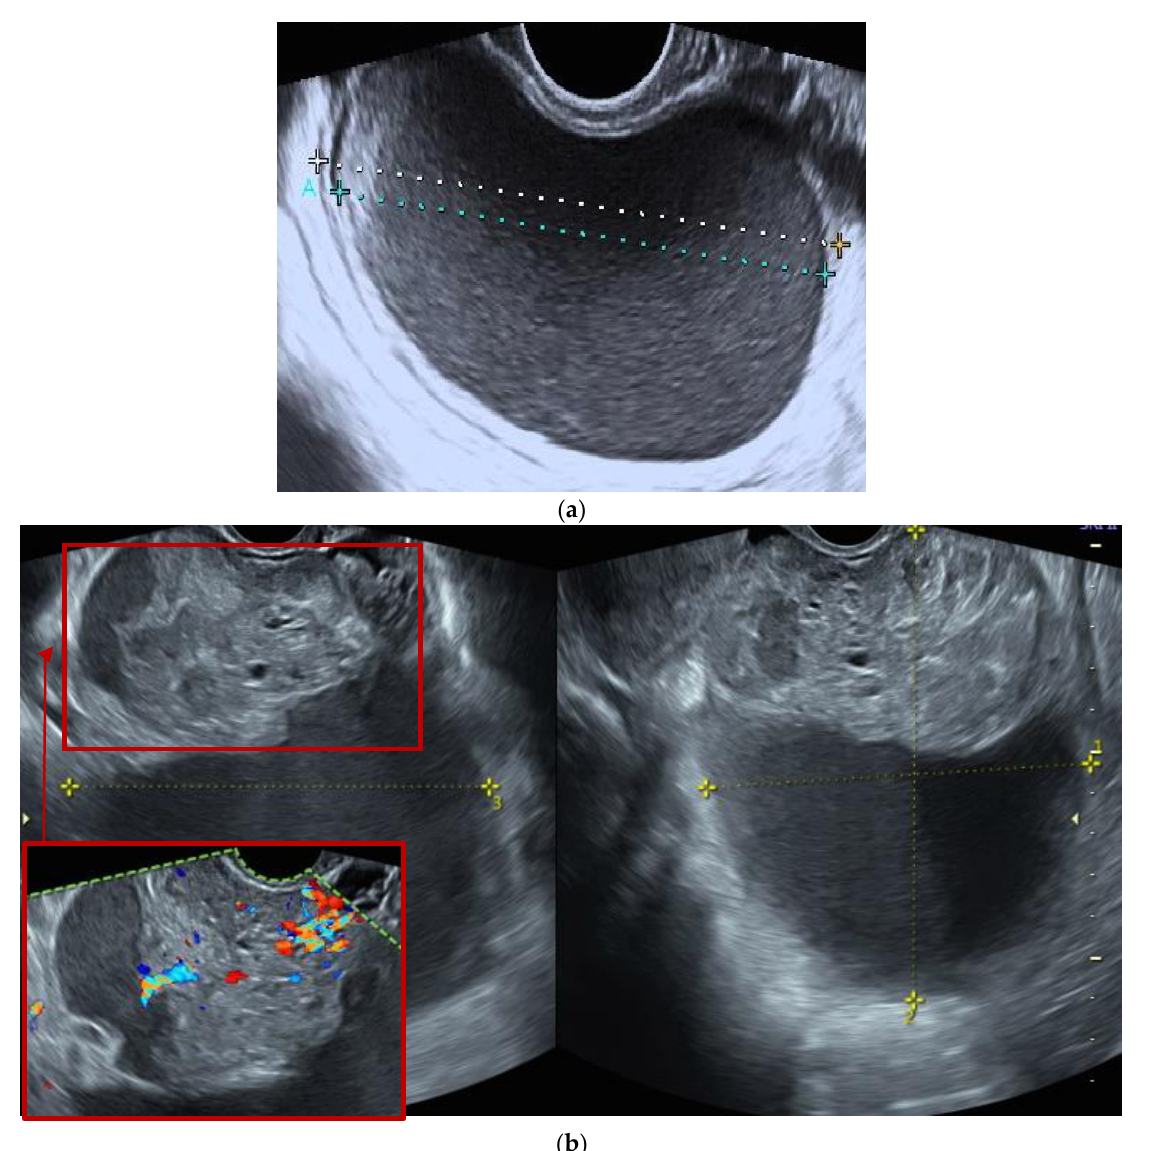
Figure 3. Ultrasound features of an ovarian mucinous carcinoma (FIGO IA stage) initially classified as a benign lesion. ( a ), Unilocular ovarian formation with “ground glass” content and color score 1 with 72 × 69 × 46 mm, observed in an asymptomatic pre-menopausal woman (age: 46 years), classified as benign by the IOTA ADNEX model and labeled as a possible endometrioma. ( b ) The same lesion with increased sonographic morphological complexity observed at the 2nd evaluation, 3 months after the initial diagnosis (multilocular — solid tumor with color score 3, CA-125 46 U/mL), associated with persistent pelvic pain referred by the patient as moderate with two weeks duration.